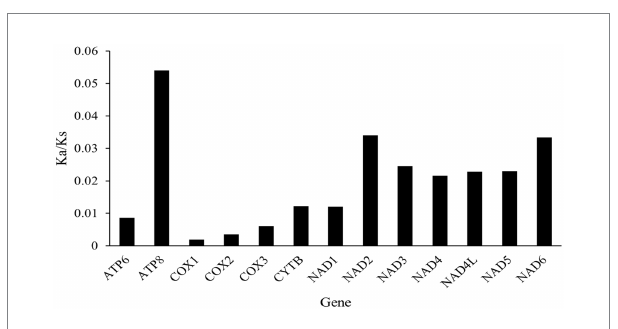
FIGURE 3 The Ka/Ks ratios of the 13 different mitochondrial genes in Cypraeidae